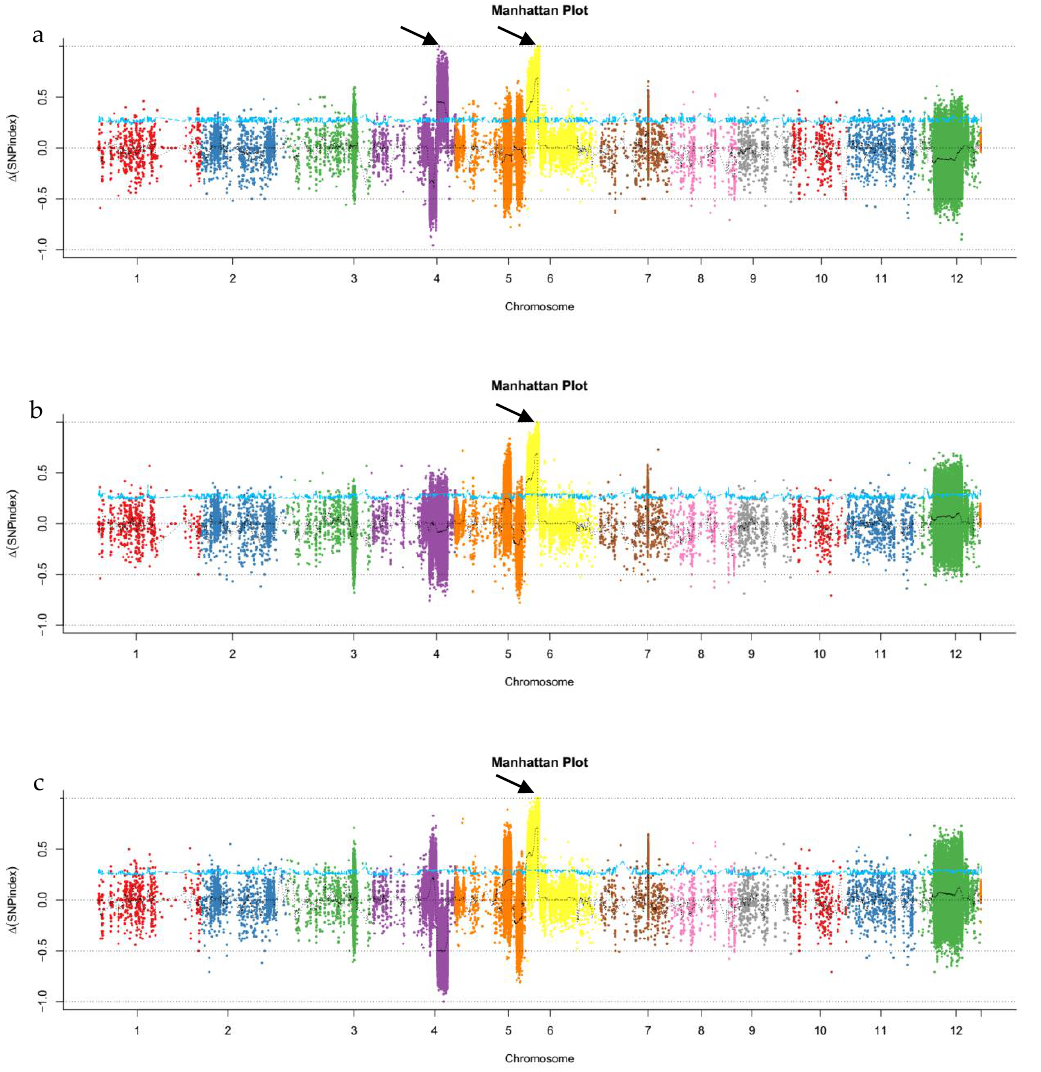
Figure 3. Two generations of the delta_All-index distributed on chromosomes. ( a ) pl1–pl2 pool, ( b ) pl1–pl3 pool, and ( c ) pl1–pl4 pool. The black arrow points to the BSA location range.